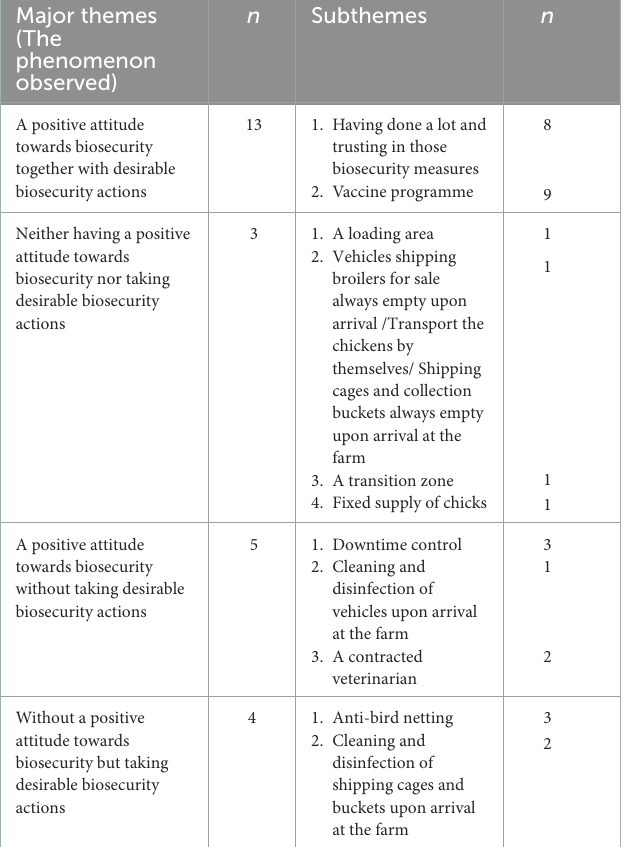
TABLE 1 Summary of themes emerging from the interview data ( n =